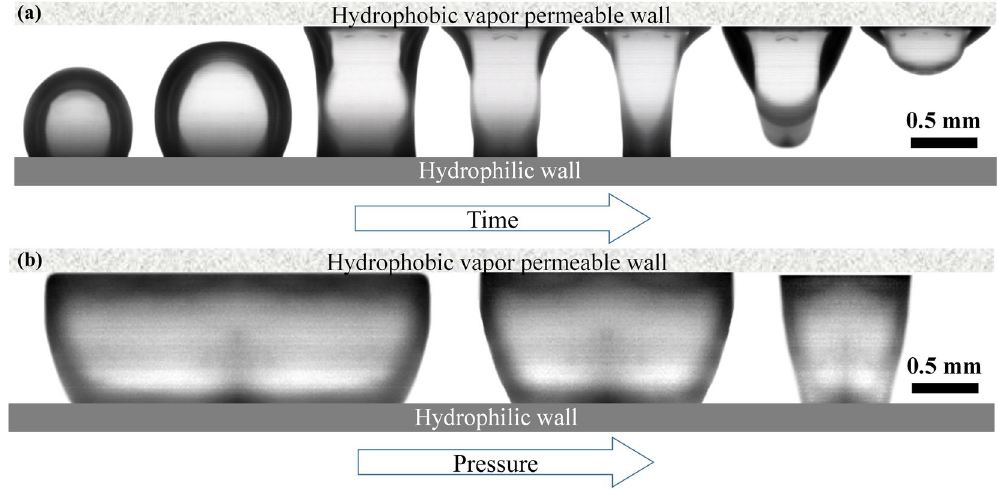
Figure 1. Bubble extraction from a channel filled with water as a function of ( a ) time and ( b ) channel